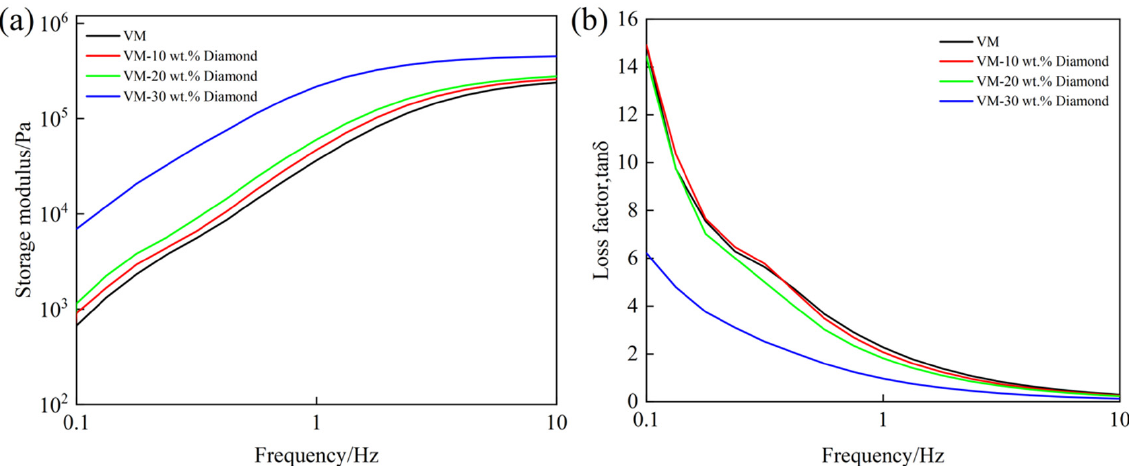
Figure 4. Rheological curves of the shear dilatancy material: ( a ) storage modulus curves; ( b ) loss factor curves.